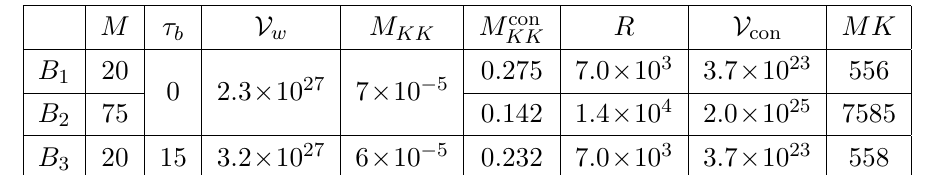
Table 1 . All points A i have τ c = T = 40 (corresponding to the fully warped conifold) and fixed H = 10 − 15 , g s = 0 . 2 . Masses are given in TeV and volumes are in string units. See main text for discussion.